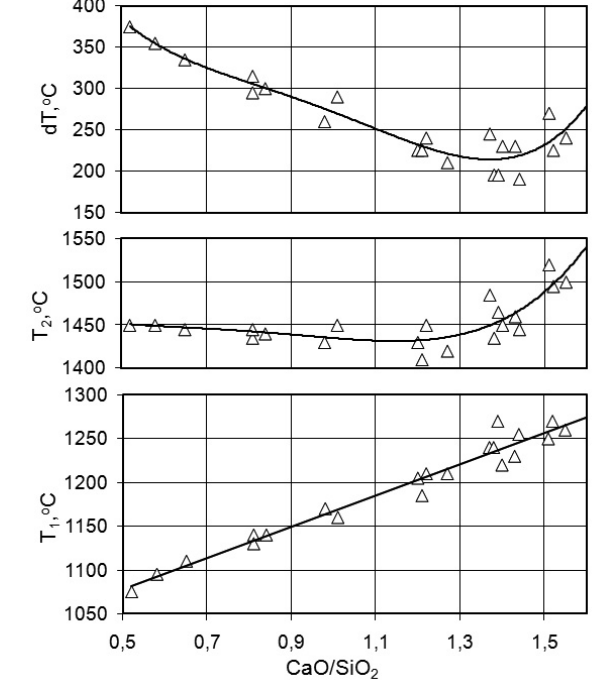
Figure 3. Influence of the basicity on T 1 , T 2 and d T .